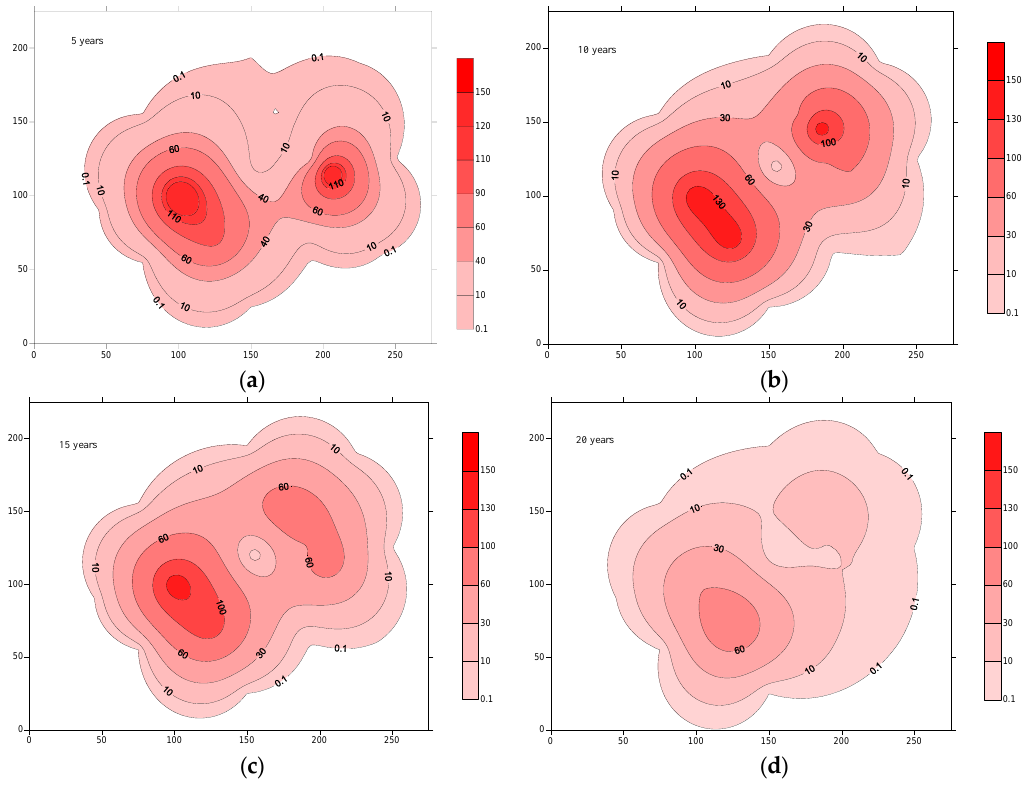
Figure 4. Simulated benzene concentrations for four remediation durations when the environmental standard is 150 μg/L and acceptable health risk level is 0.00044, where (a), (b), (c), (d) are results under the conditions of remediation duration values being 5, 10, 15 and 20 years, respectively.